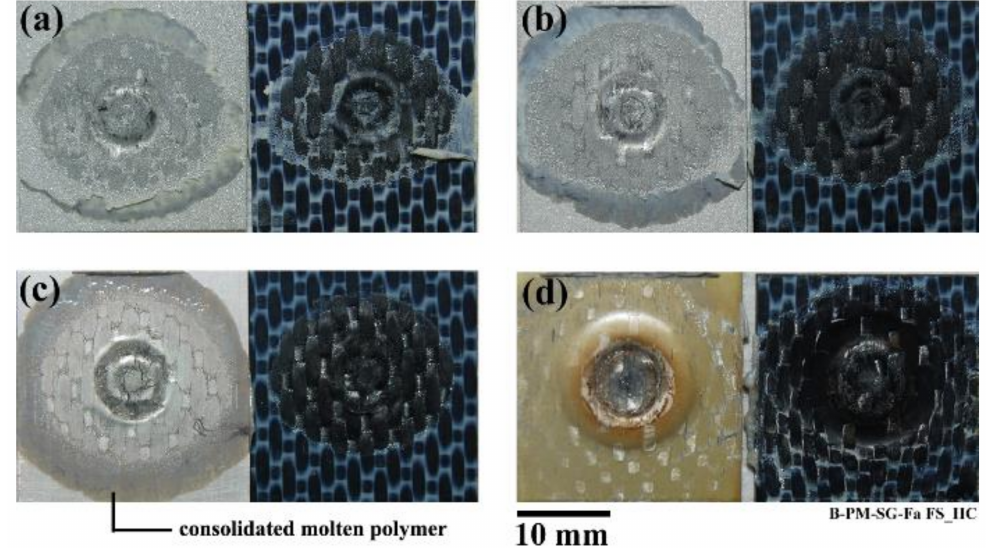
Figure 6. Fracture surface of the HC fatigue specimens: ( a ) SB—606,281 cycles to failure, ( b ) SB + CC—129,406 cycles to failure, ( c ) PAA—482,136 cycles to failure, and ( d ) PAA-P—442,673 cycles to